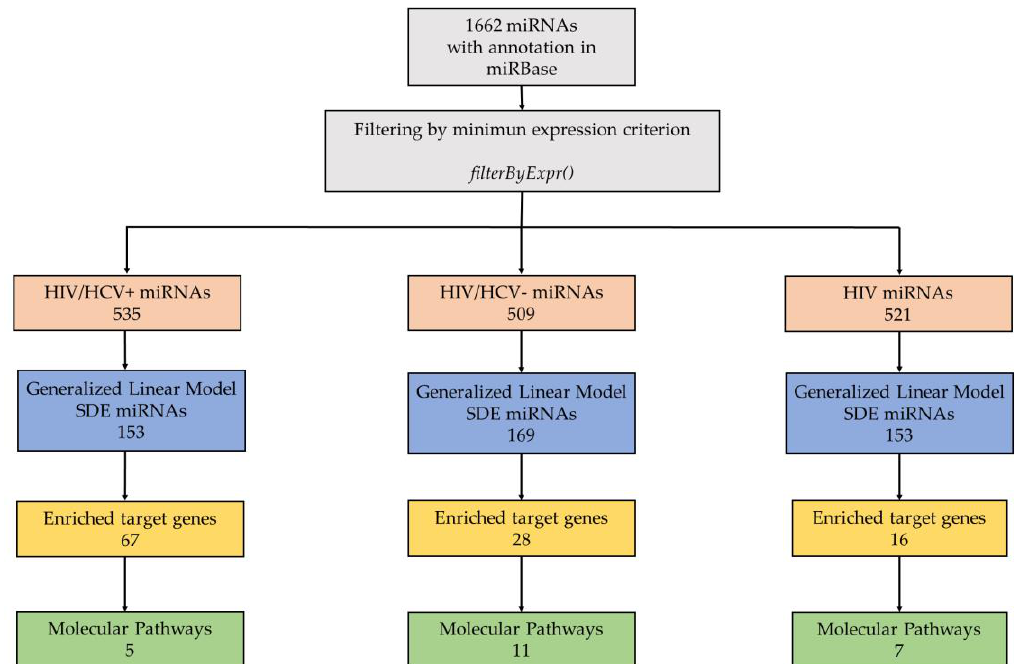
Figure 1. miRNA sequencing analysis and summary of results. Schematic representation of miRNA data analysis and results with respect to the healthy control group. The top grey square shows the total PBMC’s miRNAs in our raw expression matrix with annotations in miRBase. Minimum expression criterion was used to filter out miRNAs with no informative expression. The resulting miRNAs were subject to differential expression analysis (orange). Differentially expressed microRNAs of PBMCs in the HIV groups, their target genes and molecular pathways are represented by blue, yellow and green, respectively.